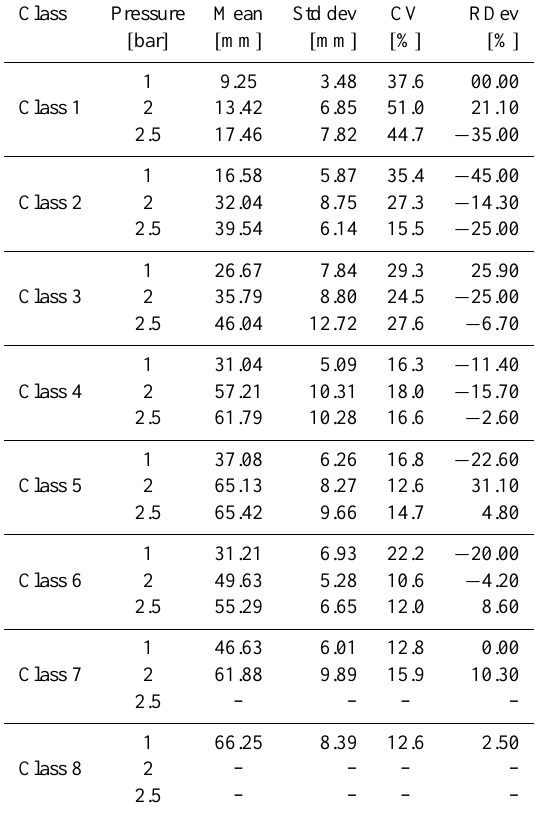
Fig. 6. Relationship between wiper frequency ( W ) and rainfall intensity ( R ) using manually (left panel) and automatically (right panel) adjusted wiper activities and the tipping bucket as the reference using a Ford SMAX as test car.